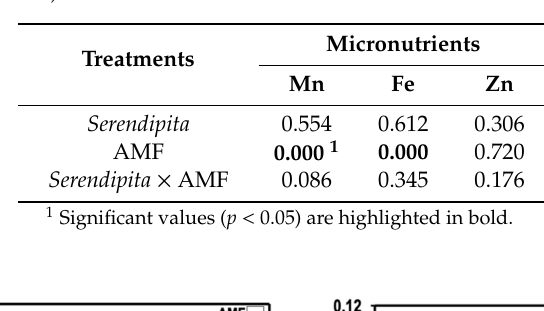
Table 5. Results of the two-way ANOVA ( p -values) for micronutrient concentration in the tomato shoots nine weeks after transplanting with the factors ‘ Serendipita ’, ‘AMF’, and ‘ Serendipita × AMF’ interactions ( p < 0.05, n = 4).